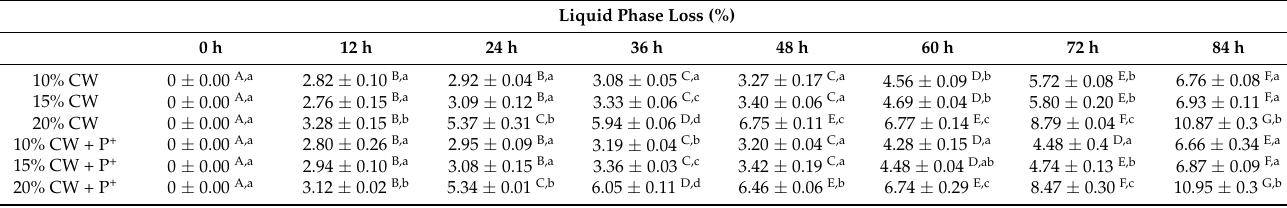
CW: Candelilla wax; P + : phosphorus. Values are shown as the mean ± standard deviation of four replicates. Means are represented by different lowercase letters in all columns at each time, and uppercase letters in lines at different oleogel formulations indicate that the samples are statistically different ( p <